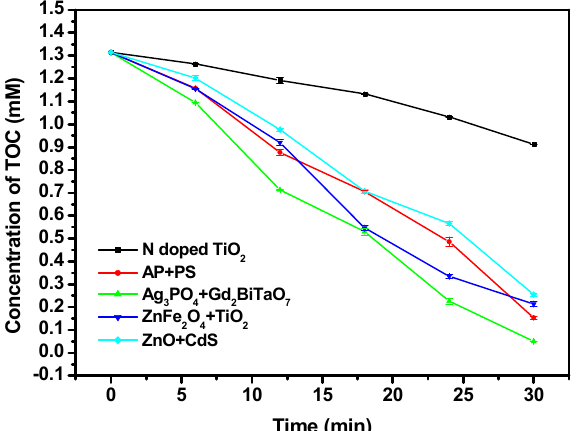
Figure 16. Concentration variation curves of total organic carbon during photocatalytic degradation of bisphenol A in pharmaceutical wastewater with Ag 3 PO 4 /Gd 2 BiTaO 7 heterojunction as photocatalyst, with N-doped TiO 2 as photocatalyst, with Ag 3 PO 4 and potassium persulfate as catalysts, with ZnFe 2 O 4 -TiO 2 nanocomposites as photocatalyst or with ZnO/CdS hierarchical heterojunction as photocatalyst under visible light irradiation.